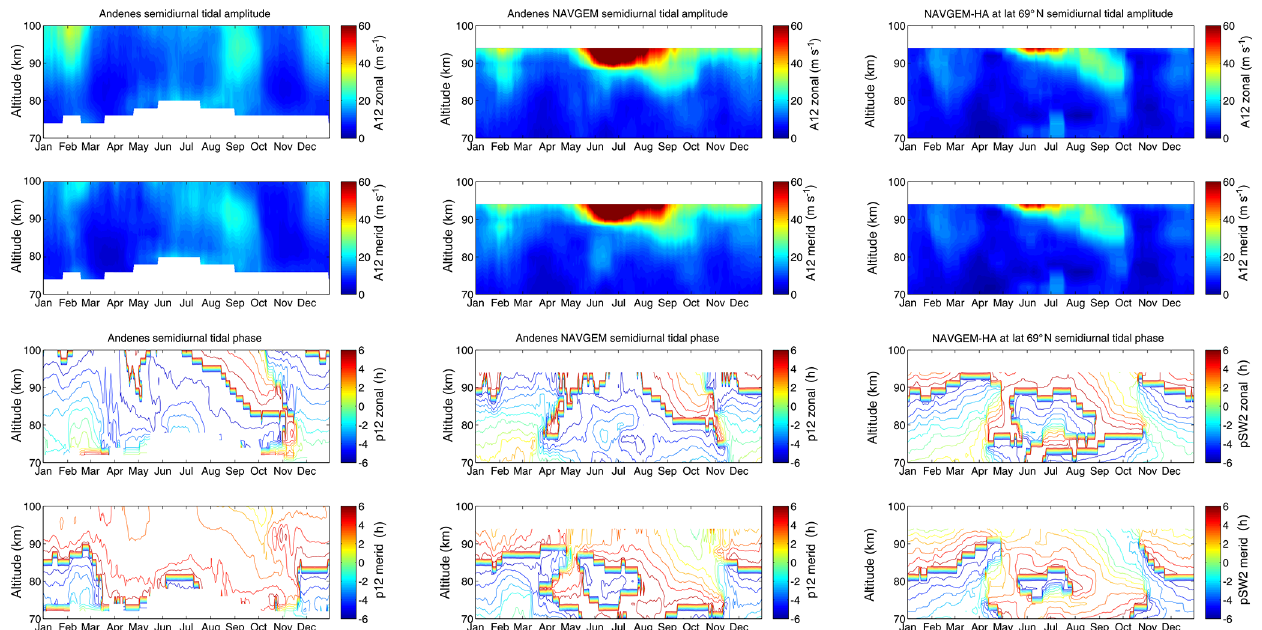
Figure 3. Comparison of semidiurnal seasonal zonal and meridional amplitude (two upper rows) and phase (two lower rows) tidal climatology using a 30d running median with periodic boundary condition. The left panels show the meteor radar observations above Andenes (69 ◦ N, 11 ◦ E). The central panels show the NAVGEM-HA analysis fields for the same period. The right panels visualize the zonal mean tidal amplitude and phase of the SW2. The labels A12 and p12 correspond to the semidiurnal amplitude and phase using the local diagnostic.